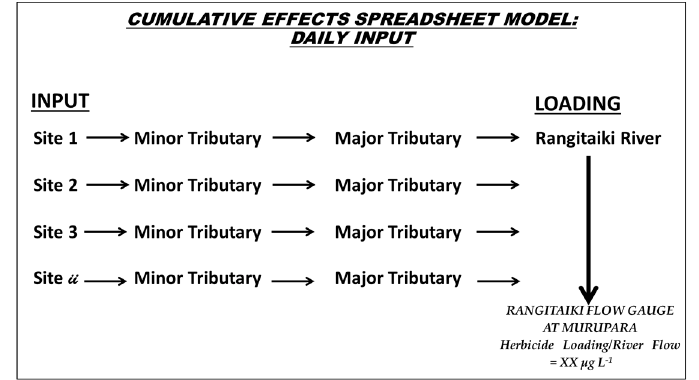
Figure 4. Excel—based herbicide cumulative effects model, Rangitaiki flow gauge at Murupara, New Zealand, 2012–2014.